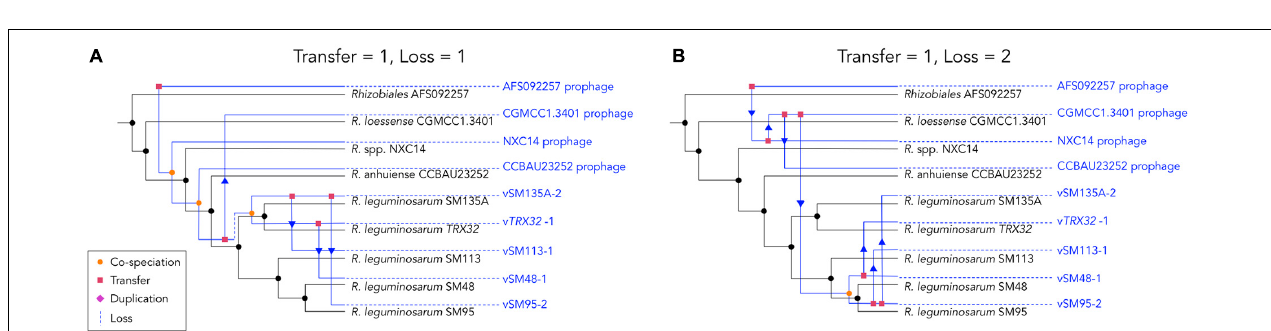
FIGURE 6 | Maximum parsimony reconciliations for prophage and lysogen phylogenies. Trees show a randomly selected example of possible evolutionary events explaining the discordance between phylogenies under two sets of cost parameters. (A) Shows one of 20 possible reconciliations where loss is equal to transfer (loss = 1, transfer = 1). (B) Shows one of 38 possible reconciliations where loss is less likely than transfer (loss = 2, transfer = 1). Host trees are shown in black while estimated phage trees are shown in blue.